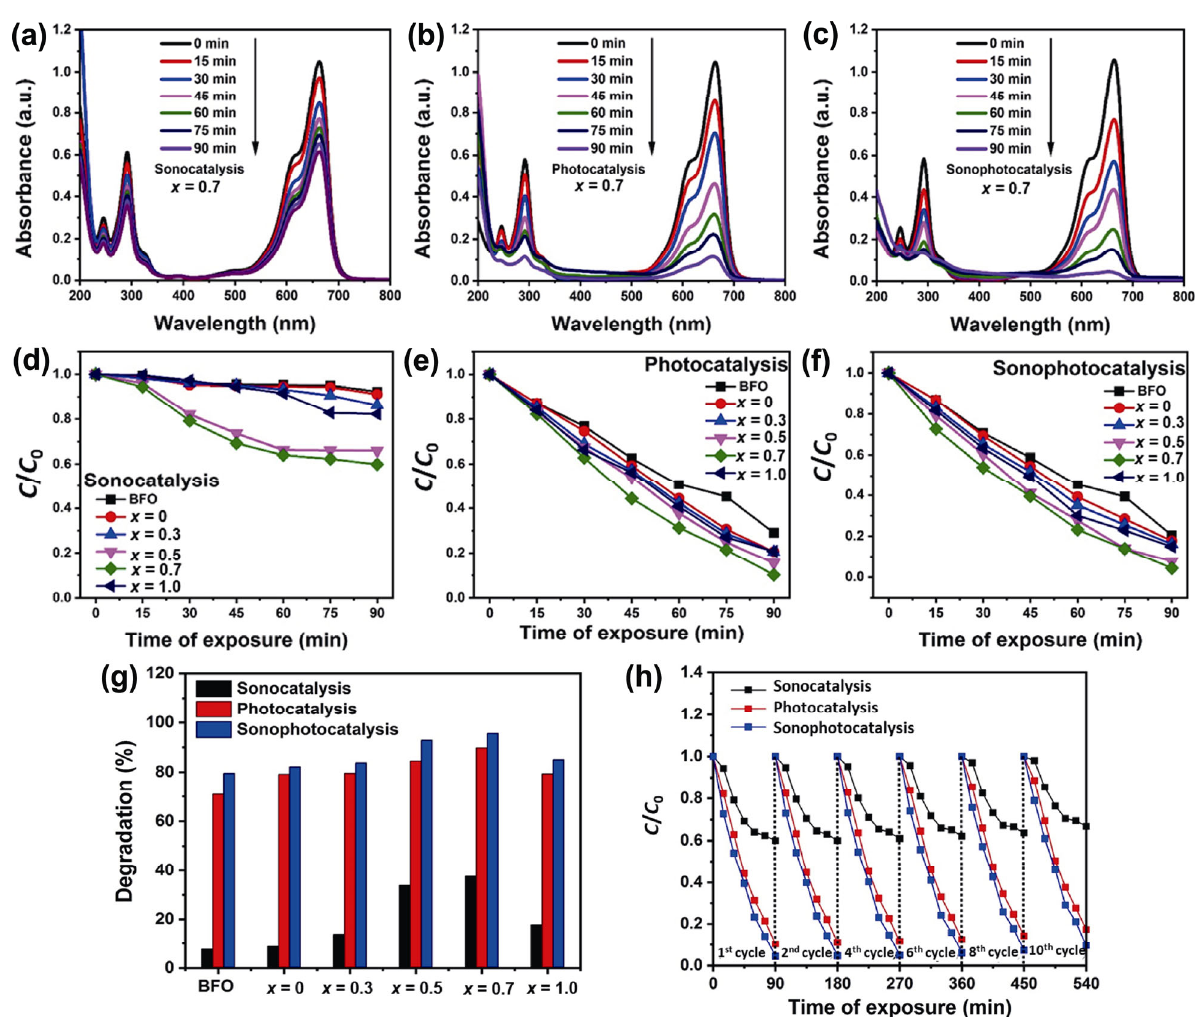
Fig. 6 Catalytic degradation performance of MB under different stimuli: (a–c) absorption spectra of MB solution after the degradation test using Bi 0.9 Gd 0.07 La 0.03 FeO 3 nanotube with different exposure times under three different stimuli. (d–f) C / C 0 ratio of MB solution as a function of exposure time under three different stimuli. (g) Degradation efficiency under different stimuli for different Gd doping ratios and (h) degradation of MB under different stimuli for 10